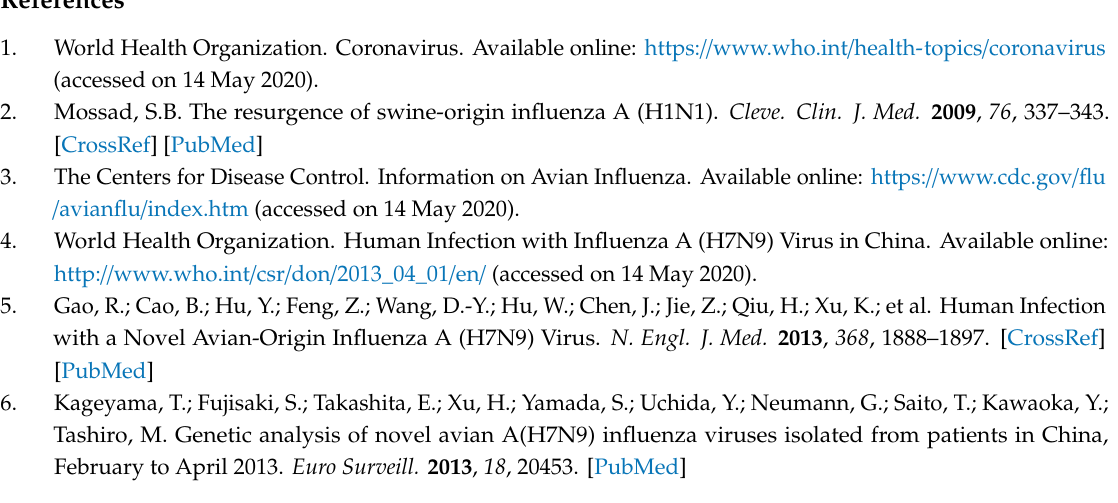
Table S1: Solicited local and systemic adverse reactions in the six days after vaccination or revaccination. Table S2: Laboratory abnormalities in the six days after vaccination or revaccination. Table S3: Results of RT–PCR testing of volunteers’ nasal swabs after immunization with A / 17 / Hong Kong / 2017 / 75108 (H7N9) LAIV and detection of vaccine virus by culturing nasal swabs in embryonated chicken eggs. Table S4: Stability of attenuating mutations in internal genes of H7N9 LAIV clinical isolates. Table S5: Reproductive activity of the A / 17 / Hong Table S6: Antibody increases in volunteers after vaccination with H7N9 LAIV or placebo, as measured in di ff erent assays. Figure S1: Subject disposition flow diagram. Figure S2: Gating strategy for analysis of virus-specific T-cell populations in peripheral blood of subjects immunized with H7N9 LAIV or placebo. Form S1: Subject information sheet and participants’ inform consent form B